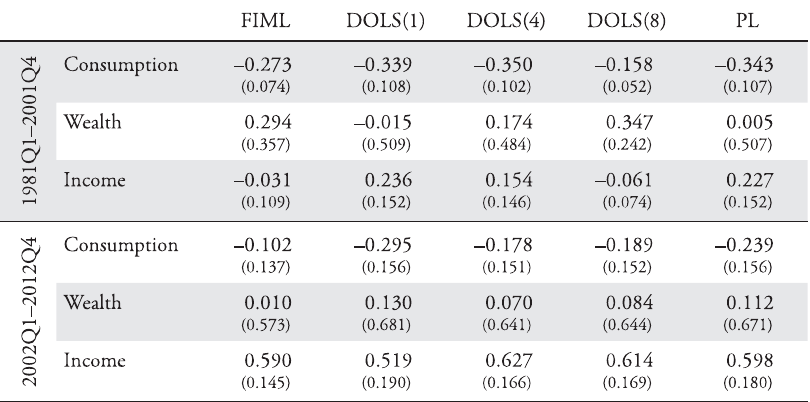
Table 5: Short-Run Dynamics: Response to Disequilibrium from VAR(2) FIML DOLS(1)